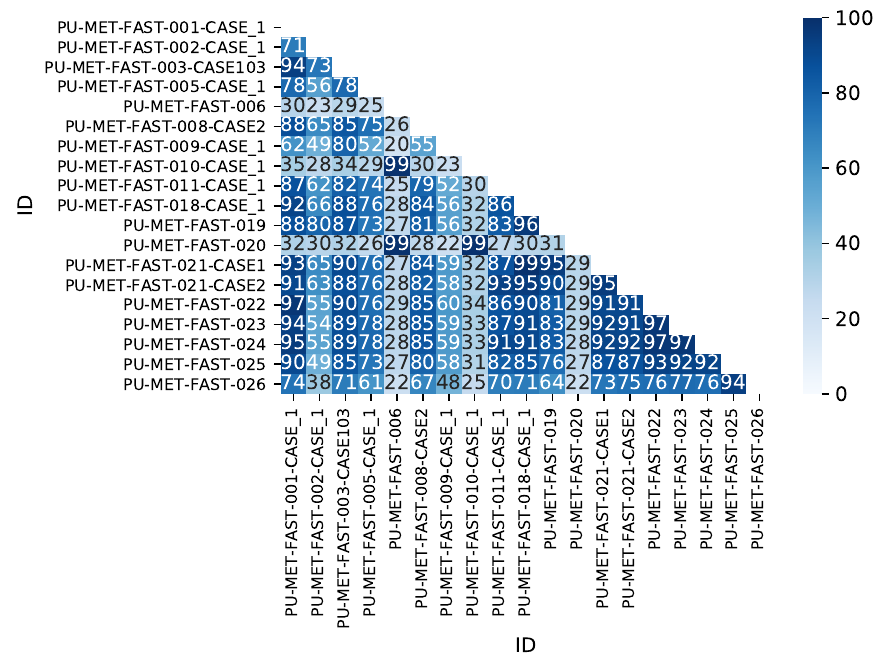
Figure 2: k e ff correlation matrix for ICSBEP PU-MET-FAST benchmarks generated by nu- clear